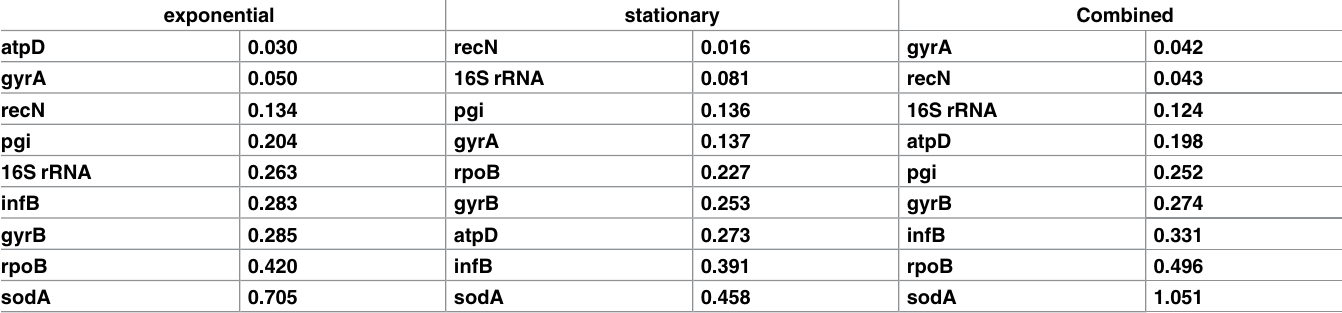
Table 6. Gene expressionstability rankings for different growth phase in A . paragallinarum serovarB analyzed by NormFinder. exponential stationary